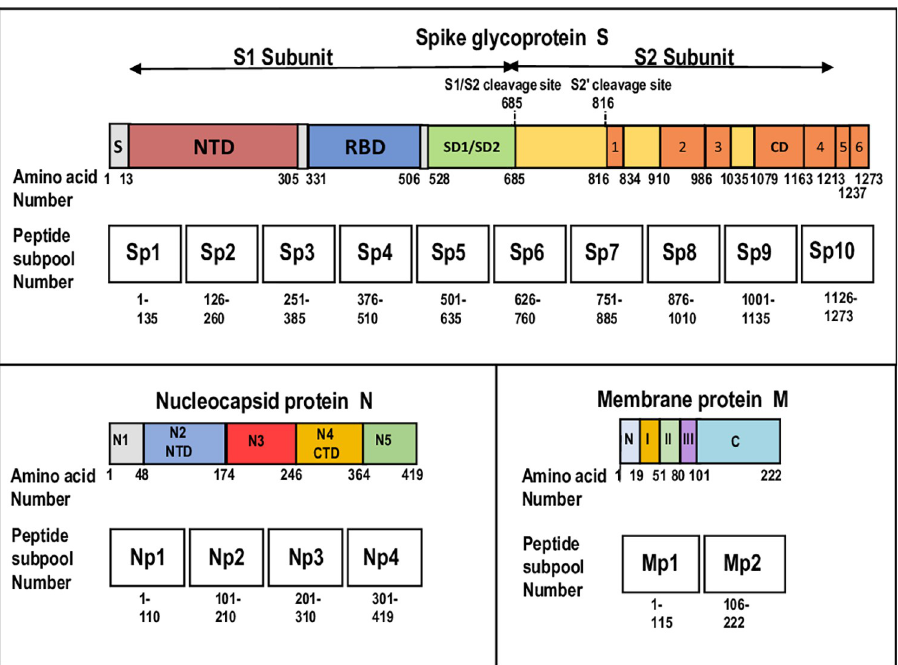
Fig 1. S, N, and M peptide subpools and their relationship to each protein structure. The structures of the S glycoprotein, and N and M proteins and their individual domains are aligned with the peptide subpools for each protein. Since constituent 15mer peptides partially overlap, each subpool also partially overlaps adjoining subpools. Consensus amino acid positions are shown in each protein. Some differences are reported, for example the S heptad repeat is variously reported to end at amino acid 1211 (reference #19), and 1213 (reference #20). Spike S glycoprotein (reference #20): Signal peptide (S); N-terminal domain (NTD); RBD (receptor-binding domain); SD1/SD2 (subdomain 1 and 2); 1 (fusion peptide); 2 (HR1, heptad repeat); 3 (central helix); CD (connector domain); 4 (HR2, heptad repeat); 5 (transmembrane domain); 6 (cytoplasmic tail); the S1/S2 and S2’ cleavage sites (reference #23). S protein subpools predominantly aligned with S domains: Sp1, Sp2 NTD; Sp3 NTD/RBD; Sp4 RBD; Sp5 SD1/SD2; Sp6 SD1/SD2 including S1/S2 cleavage site; Sp7 fusion peptide; Sp8 heptad repeat; Sp9 central helix/connector domain; Sp10 heptad repeat/transmembrane domain/cytoplasmic tail. Nucleocapsid protein N (reference #24): domain N1; domain N2 (N-terminal domain [NTD] or RNA binding domain); domain N3 (contains a serine-arginine rich region); domain N4 (C-terminal domain [CTD]; domain N5. N protein subpools predominantly aligned with N domains: Np1 domains N1 and part of N2; Np2 domains N2 and N3; Np3 domains N3 and N4; Np4 domains N4 and N5. Membrane protein M (reference #26): N (NTD, N-terminal domain); I, II and III (transmembrane domains); C (CTD, C-terminal domain). M protein subpools predominantly aligned with M domains: Mp1 NTD, 1, II and III; Mp2